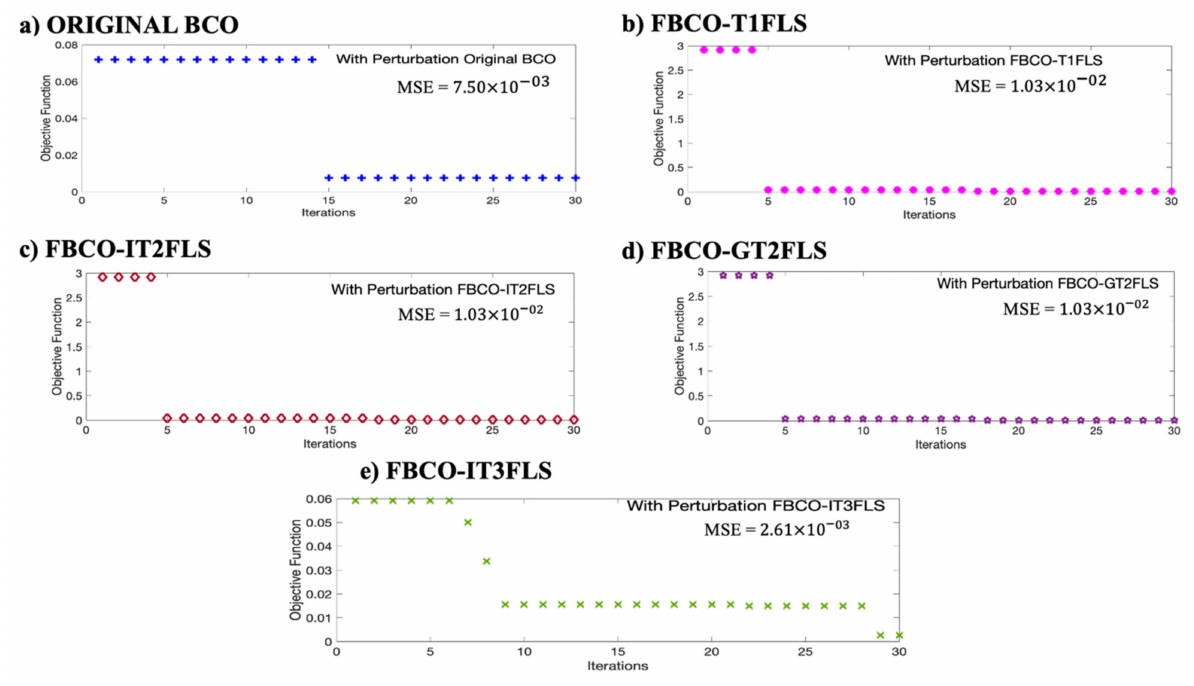
Figure 24. Comparative of the Best convergence for each Fuzzy BCO, ( a ) Original, ( b ) T1FLS, ( c ) IT2FLS, ( d ) GT2FLS and ( e )